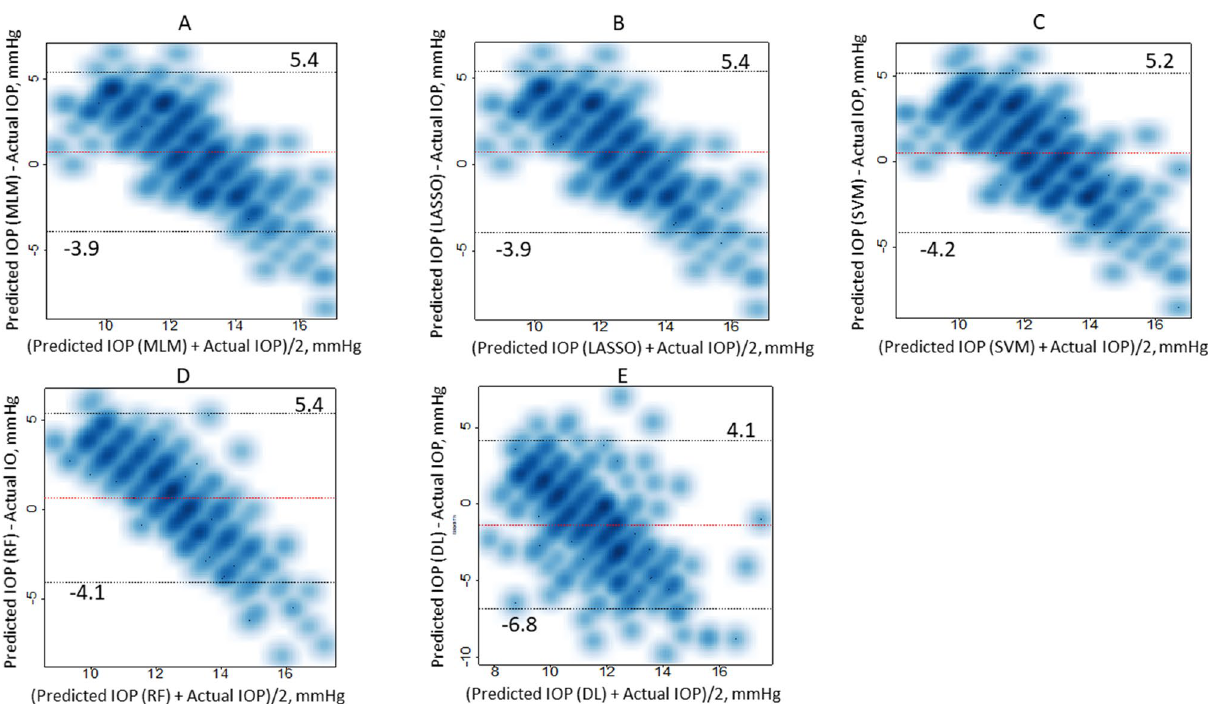
Figure 2. The relation between the predicted IOP values with each prediction method and actual IOP value, shown as a Bland–Altman plot. ( a ) MLM, ( b ) LASSO, ( c ) SVM, ( d ) RF, ( e ) DL. Data was shown as a smoothed scatter plot. MLM multivariate linear regression, LASSO least absolute shrinkage and selection operator regression, SVM support vector machine, RF random forest, DL deep